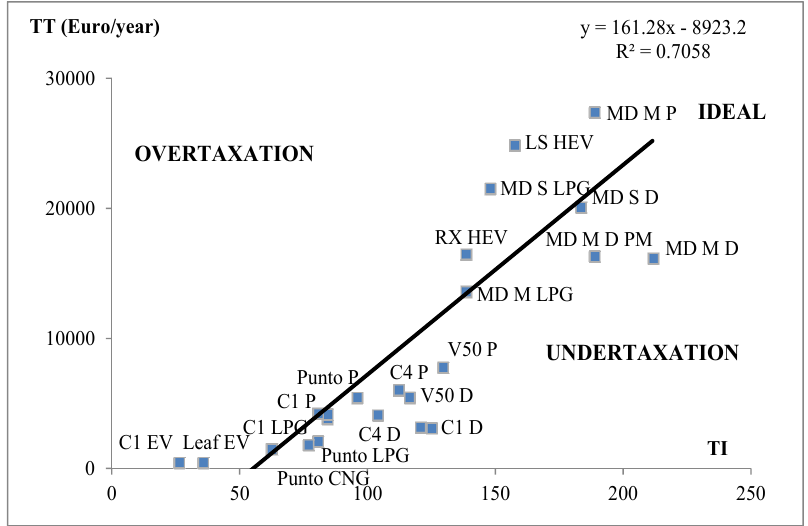
Figure 8. Total taxes (TT) and total environmental impact (TI) in CO fiscal